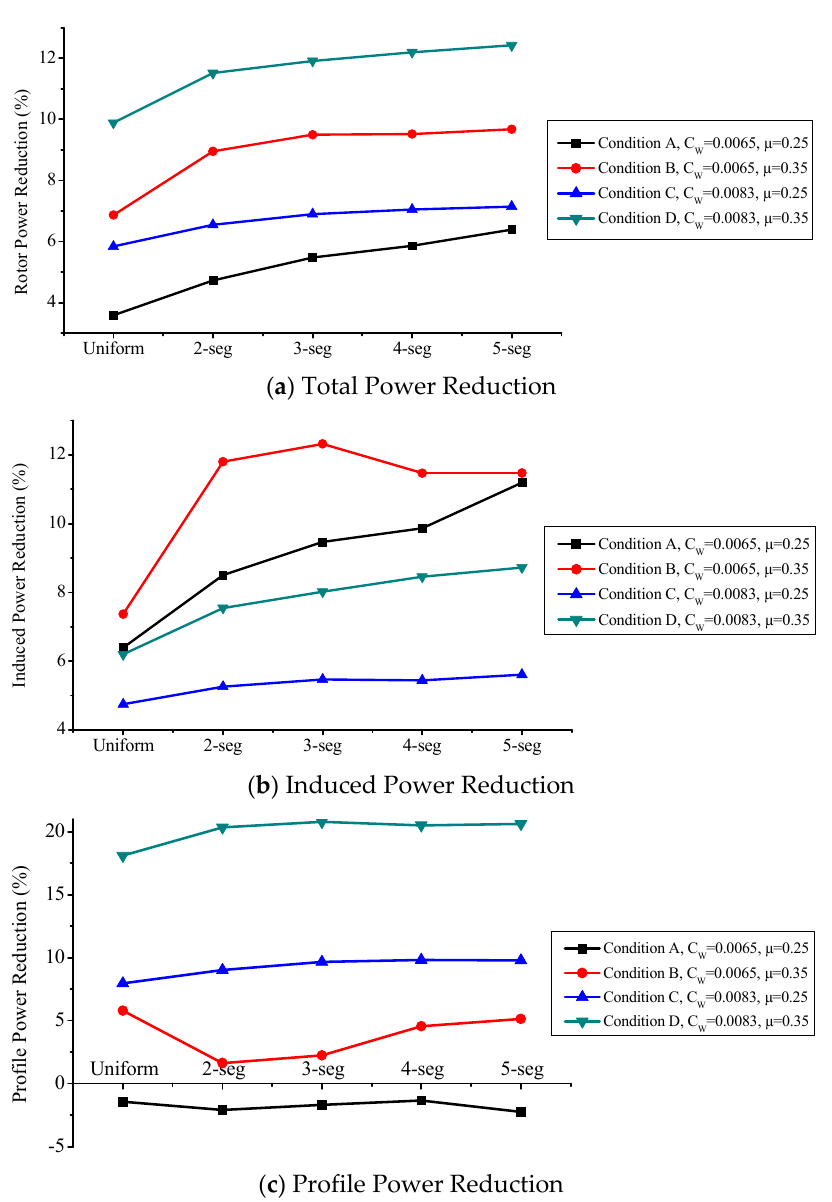
Figure 20. Rotor power reductions using segment twist control for condition B. For condition A, the rotor power reductions that are obtained by the 2-, 3-, 4-, and 5-seg control are 4.72%, 5.47%, 5.85%, and 6.39%, respectively. For condition B, the rotor power reductions are 8.95%, 9.49%, 9.52%, and 9.68%. For condition C, the rotor power reductions are 6.54%, 6.90%, 7.05%, and 7.14%. For condition D, the rotor power reductions of 11.52%, 11.91%, 12.20%, and 12.42% are achieved while using the 2-, 3-, 4-, and 5-seg control, respectively. As shown in Figure 20b,c, segment control has little effect on the profile power, while the induced power can be significantly reduced. Even for condition B, segment control has less mitigation on the induced power than the uniform twist con- trol. Regarding the weight coefficient, the power reduction obtained in the case of 0.0083 is higher than that with 0.0065. With respect to the flight speed, the gain that is obtained at an advanced ratio of 0.35 is higher than that at 0.25. Thus, the effect of active twist control on power reduction is more significant for flight conditions with a larger weight coefficient and higher flight speed.